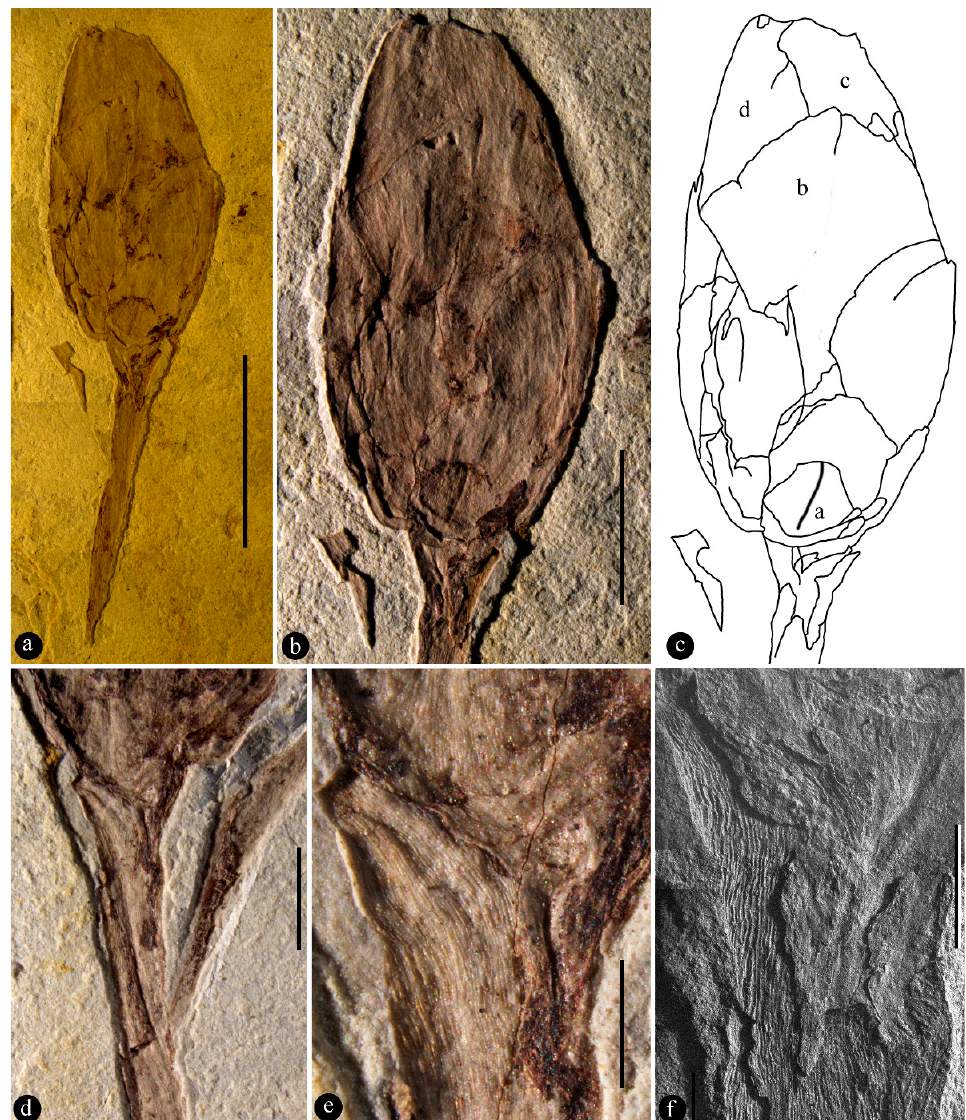
Figure 2. The holotype of Archaebuda gen. nov. and its details. ( a ) The general view of the specimen, including a stalk and a flower bud. Bar = 10 mm. ( b ) Detailed view of the bud composed of various overlapping patches. Bar = 5 mm. ( c ) Sketch of the bud in Figure 2b. Parts marked by letters (b, c, d) are shown in Fig. 3a. ( d ) Basal portion of the flower bud. Bar = 1 mm. ( e ) Detailed view of the scaly leaf with cellular details on the pedicel. Bar = 1 mm. ( f ) SEM view of the portion in Figure 2e, showing the longitudinal arrangement of the cells. Bar = 1 mm.